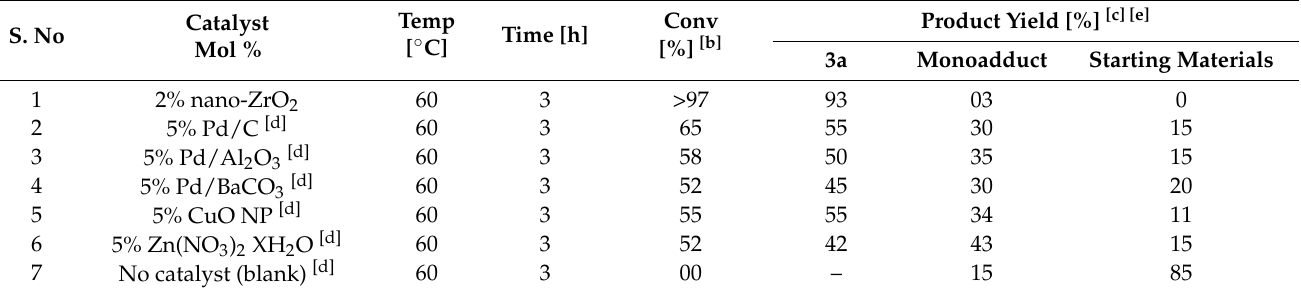
Table 2. Catalyst activity comparison [a] .